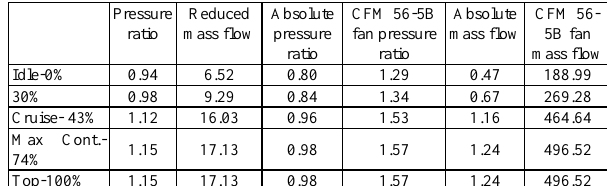
Table 9. Parameter of CFM 56-5B V = 0.44 Ma, H = 2000 m